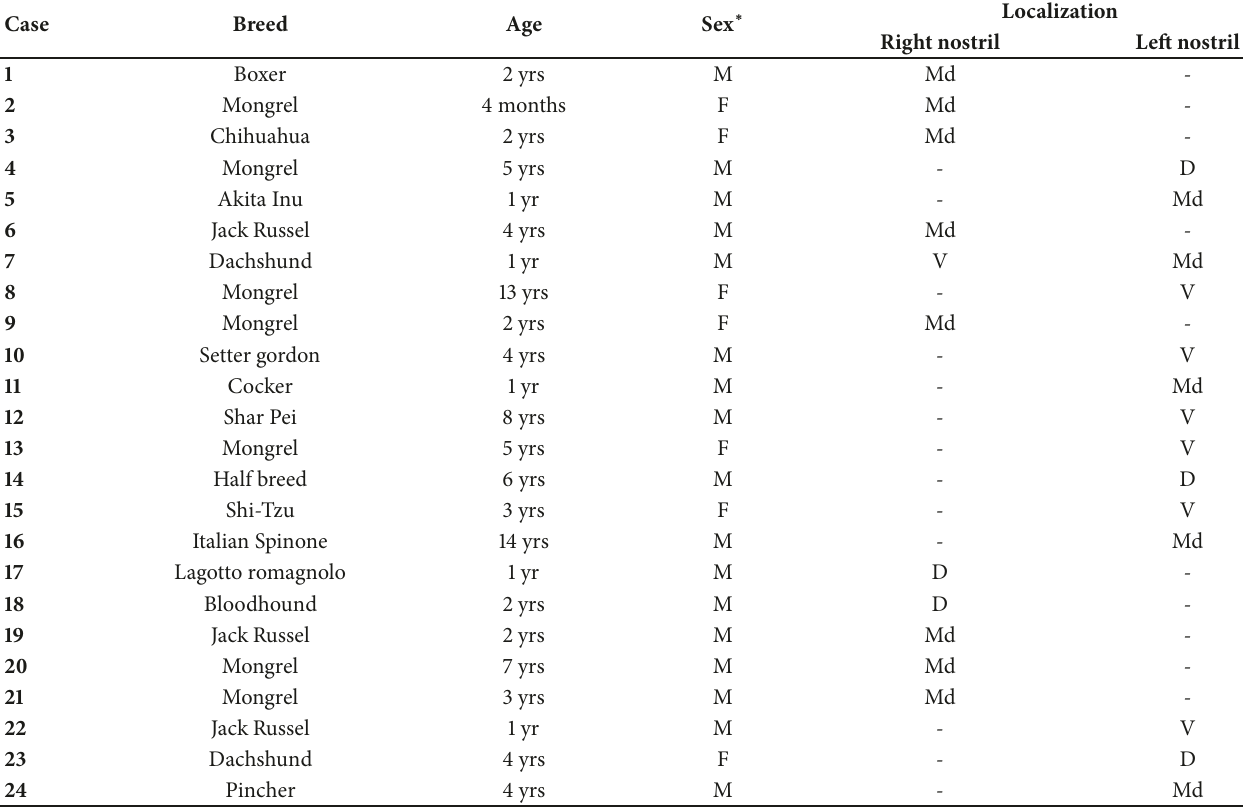
Table 1: Breed, age, and sex of dogs included in the present study and localization of the grass awns in the upper respiratory tract ( ∗ F = female; M = male; D = dorsal meatus; Md = middle meatus; V = ventral